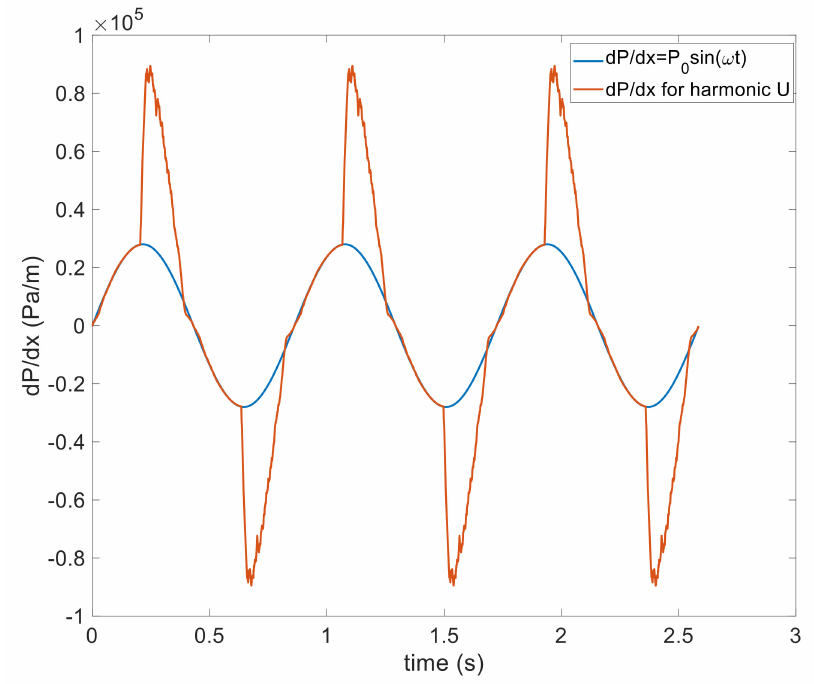
Figure 5. Comparison between the pressure gradient before and after enforcing of harmonic average flow oscillations, corresponding to Case 1: Re os = 5830, α = 2.70.